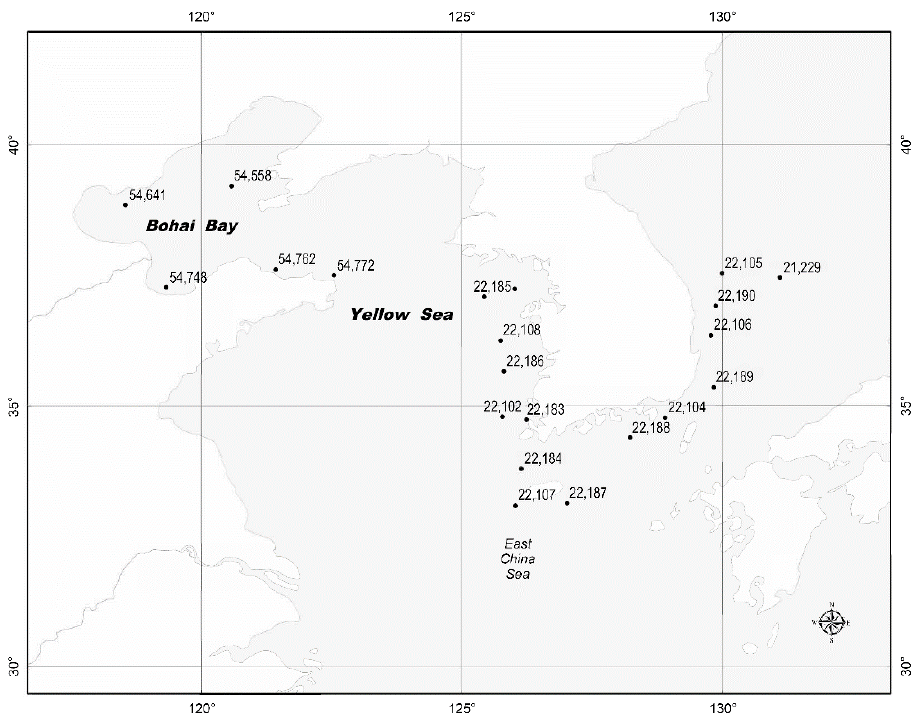
Figure 1. Region for the fusion SST verification and distribution of buoy sites. The numbers denote the station identification of buoy sites.